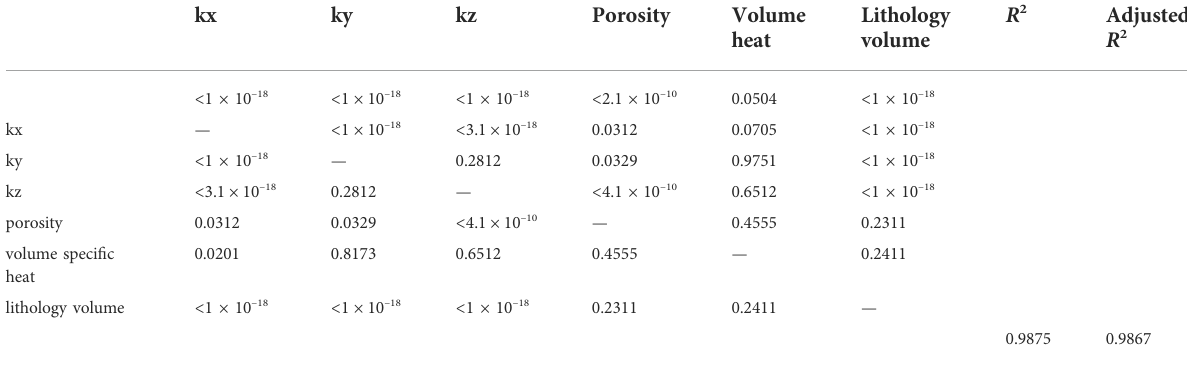
TABLE 2 The p -value of parameters applied in a fi rst-order regression model with interactions.